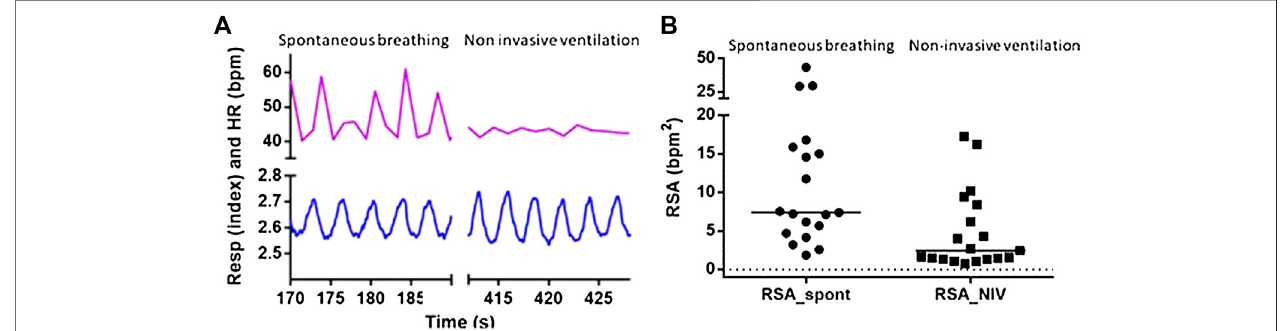
FIGURE 3 | Respiratory sinus arrhythmia was decreased by non-invasive ventilation. (A) Five respiratory cycles during spontaneous breathing and non-invasive ventilationfromonesubject.Recordingsofrespiratorystretch(bottom)andheartrate(HR,top)showthatpulmonarystretchismaintainedbreath-by-breath duringnon- invasive ventilation, while respiratory sinus arrhythmia is minimal during non-invasive ventilation. (B) Respiratory sinus arrhythmia is decreased for all nineteen subjects. One circle represents one subject and lines indicate the individual ’ s decrease in heart rate variability (HRV) from spontaneous breathing (SB) to non-invasive ventilation